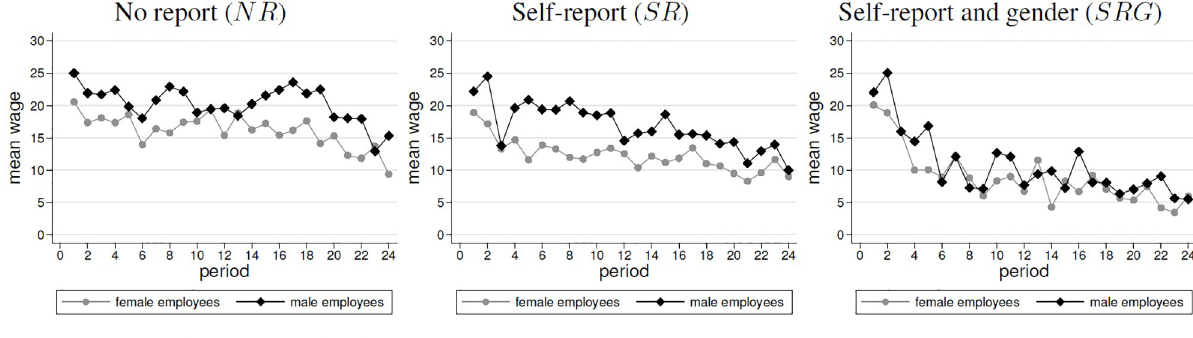
Fig 5. Average wages by treatment and